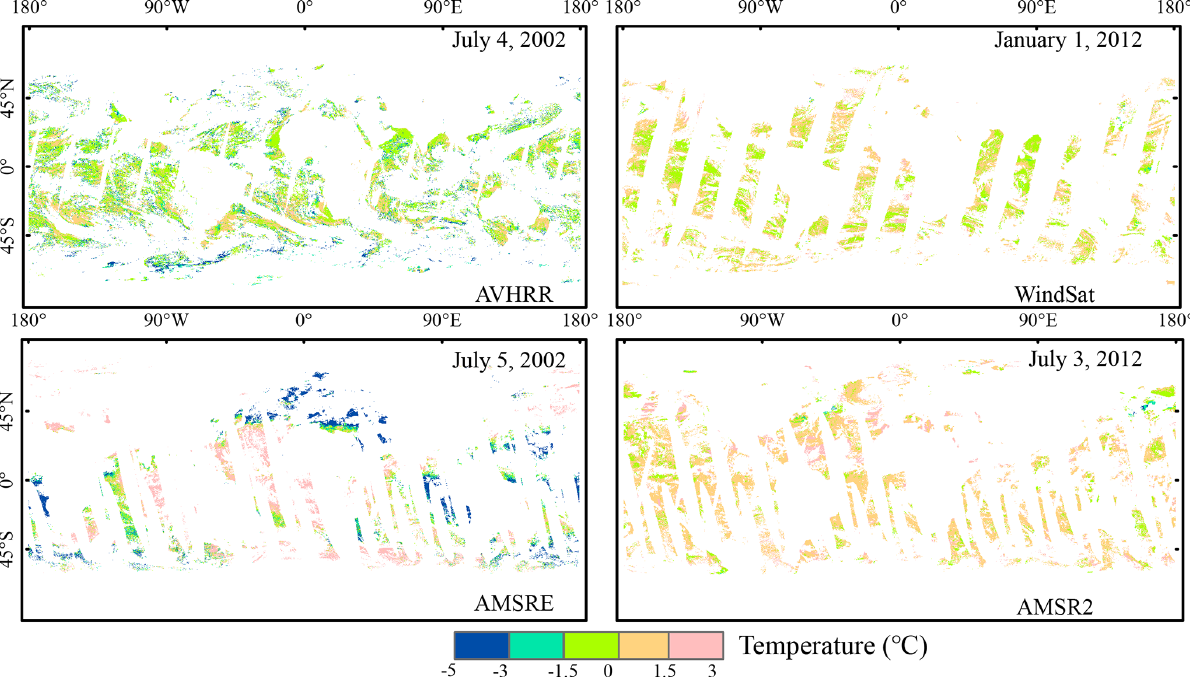
– d l > 0, d u > 0 results in double zooming near both the surface and the